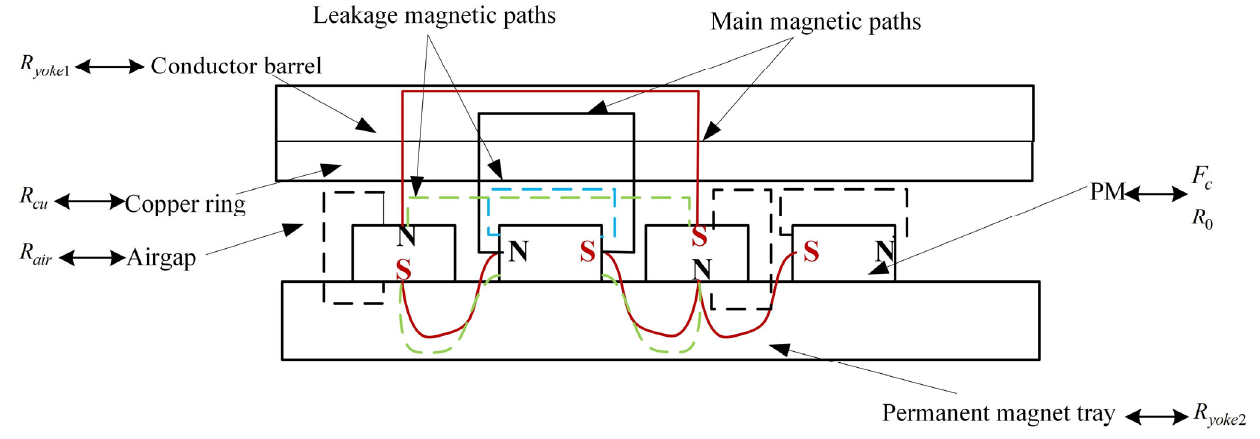
Figure 3. Equivalent magnetic model of a Halbach permanent magnet cell.